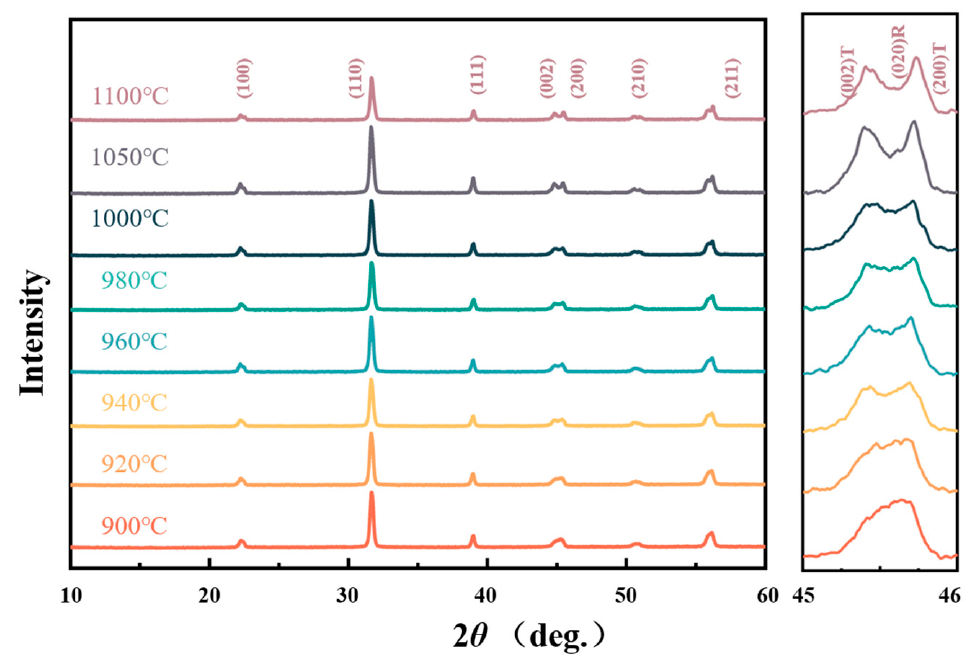
Figure 1. XRD patterns for the 0.2 wt% Li 2 CO 3 -modified bulk ceramics.